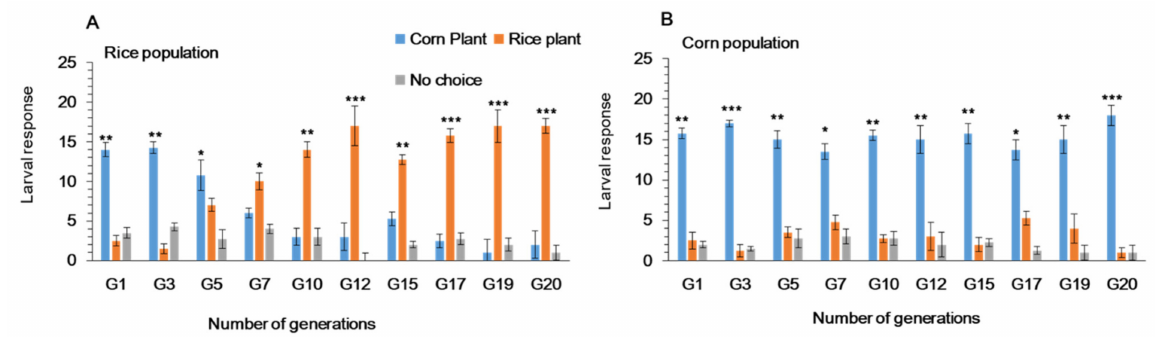
Figure 2. Feeding choice of first instars larvae of Spodoptera frugiperda in Y-tube, when reared on ( A ) rice and ( B ) corn plants for 20 generations. Data are means ± SE. Asterisks *, ** and *** show significant differences in different host plants ( p < 0.05) using Tukey multiple comparison post hoc test at p ≤ 0.05.